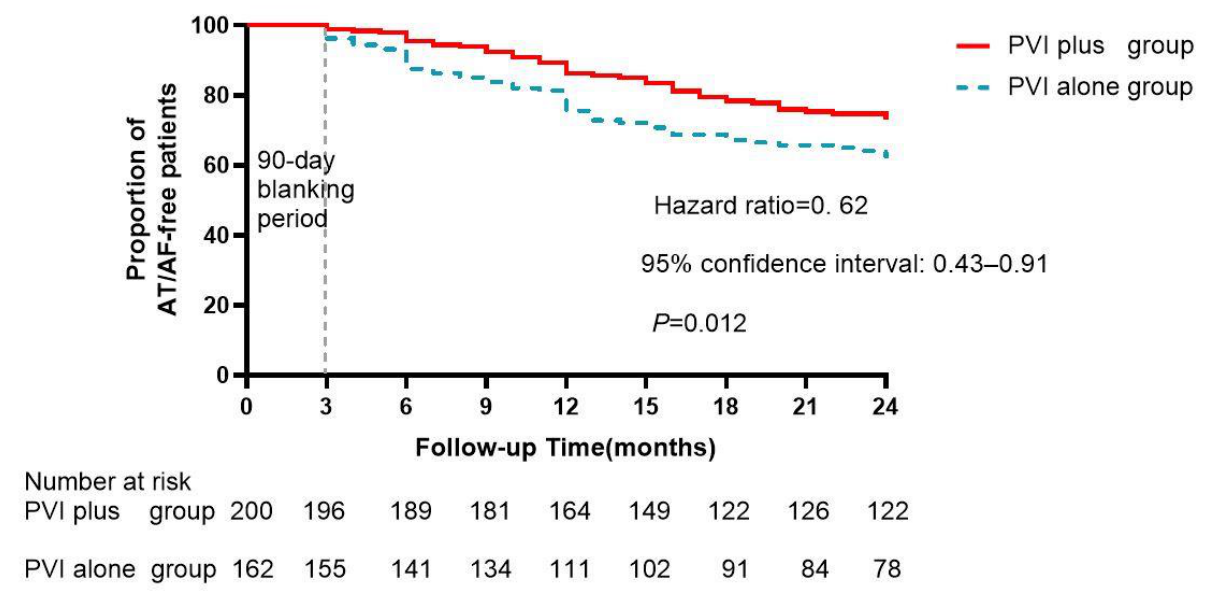
Table 4. Predictors of recurrence at follow-up in Cox regression analysis.